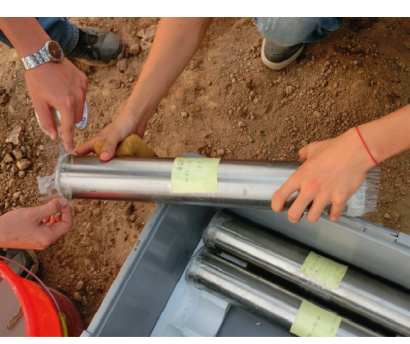
Figure 14: Cylindrical samples.